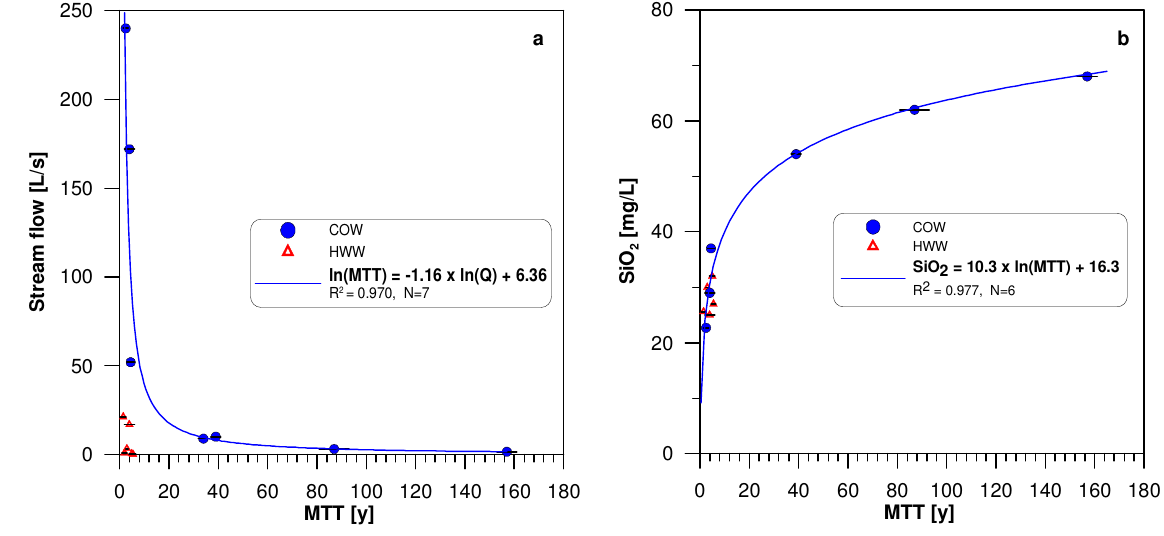
Fig. 7. (a) Streamflow and (b) SiO 2 concentration versus mean transit time (MTT). Correlations are deduced from data from the catchment outflow weir (COW)